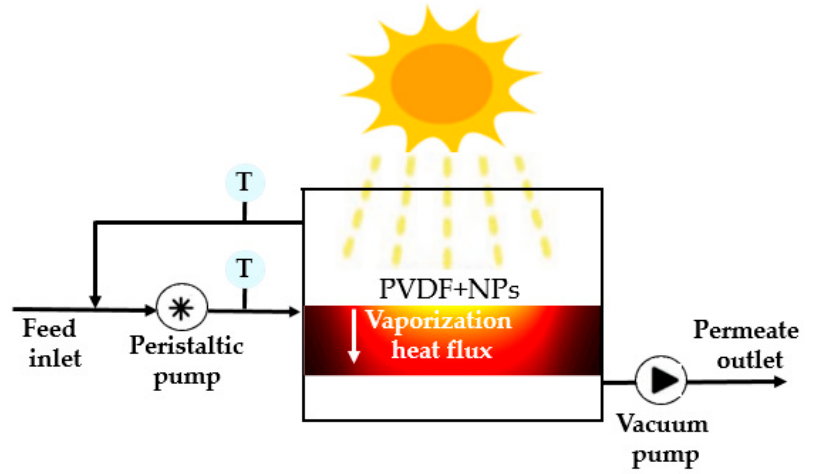
Figure 1. Schematic design of the solar driven membraneprototype. The NPs increase the tempera- ture of the membrane at its surface thanks to their efficient light-to-heat conversion. The difference in temperature between the two sides of the membrane creates a gradient of vapor concentration. This helps the diffusion of vapor flux through the PVDF membrane and enhances its rate.